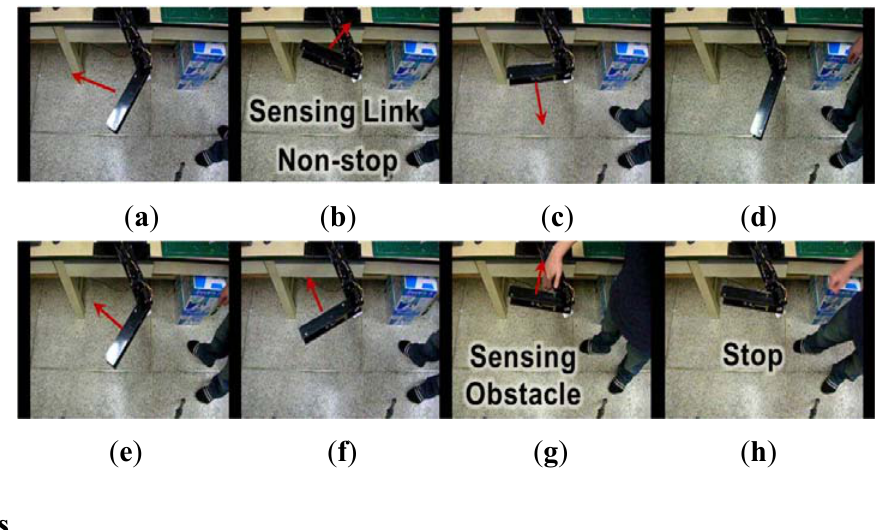
Figure 13. ( a–h ) Using an intelligent decision step, (b) the manipulator keeps moving if the sensor detects a part of the manipulator (e.g., a link) in the danger area, but (g,h) the manipulator stops when an obstacle is detected in the danger